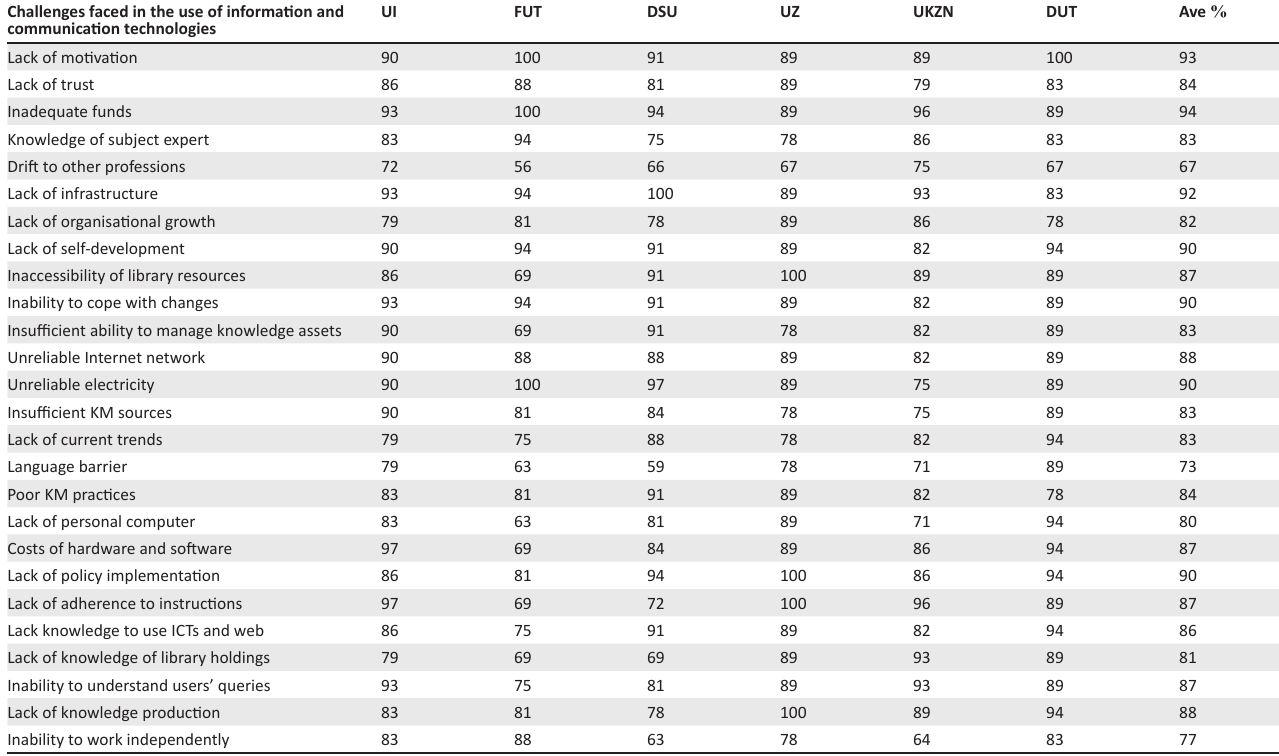
TABLE 4: Challenges faced in the use of information and communication technologies for the support of knowledge management ( % ). Challenges faced in the use of information and communication